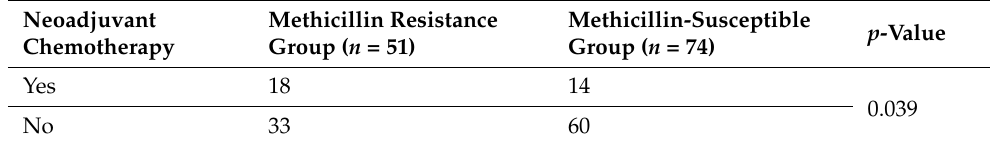
Table 2. Statistical analysis for neoadjuvant chemotherapy between the methicillin resistance and methicillin-susceptible groups.